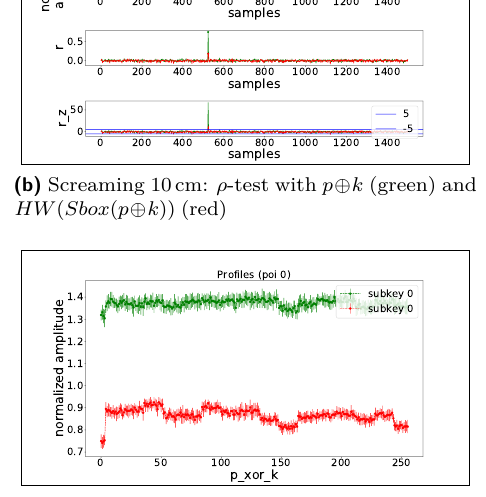
(c) Profile built with HW ( Sbox ( p ⊕ k )) for cable (green) and 10cm (red) Figure 6: Screaming channels leaks follow a distorted leak model. For both the connection via cable (a) and at 10 cm (b), choosing HW ( Sbox ( p ⊕ k )) (red) drastically decreases the ρ -test correlation compared to choosing Sbox ( p ⊕ k ) or p ⊕ k (green). Profiles for cable and 10 cm (c)(d) are similar, but they differ from the conventional case.